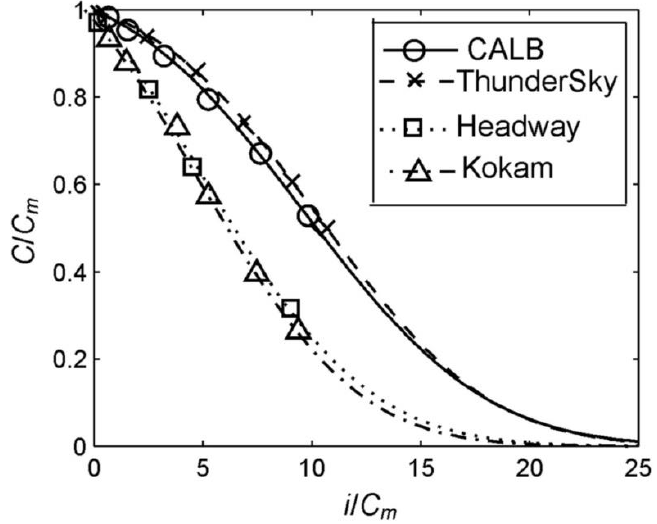
Figure 3. Comparison between experimental data for automotive-grade lithium-ion batteries and Equation (12). Value C m is taken from Table 3 for each battery. Table 3. Optimal values of parameters of Equations